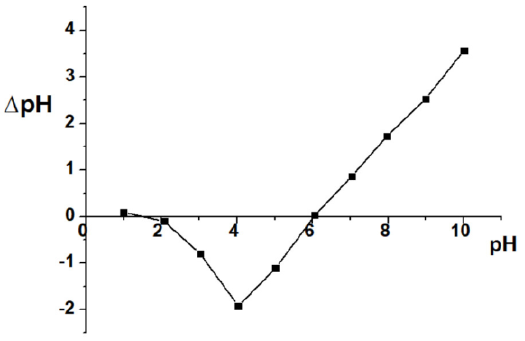
Figure 5. Isoelectric point of